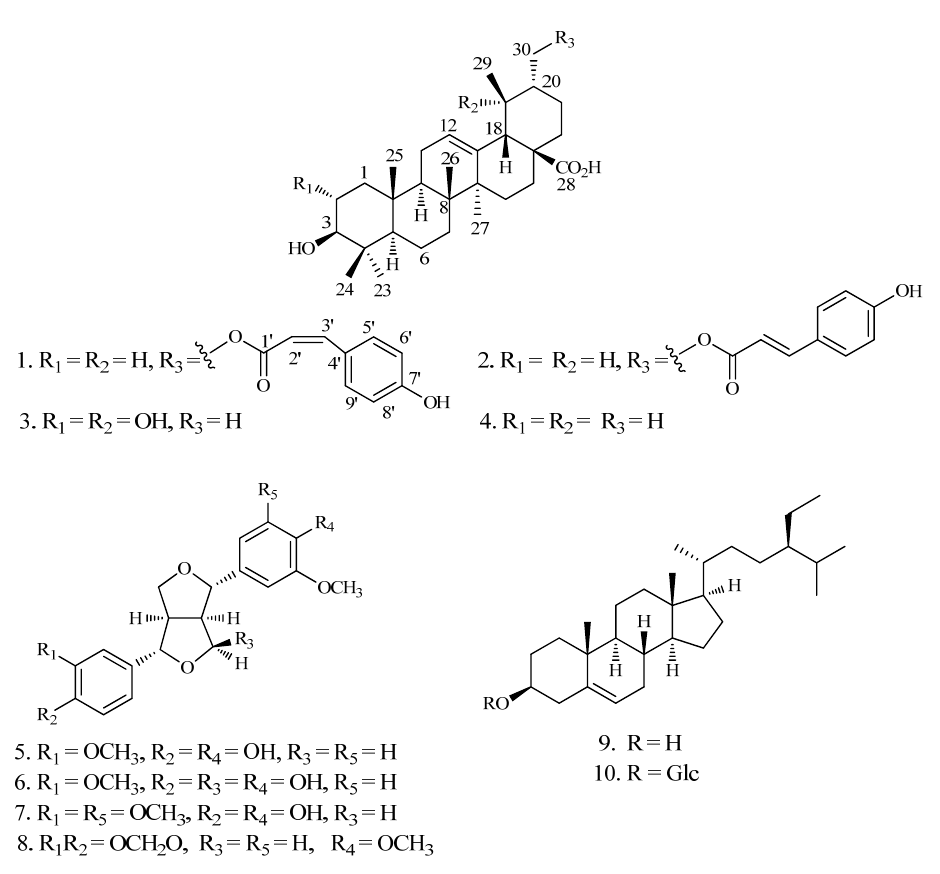
Figure 1. Structures of compounds 1 – 10